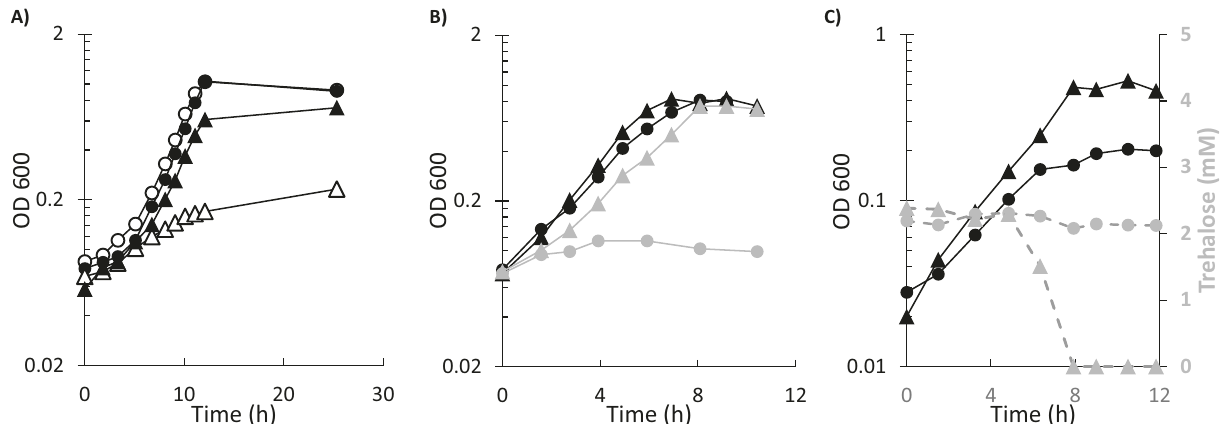
Fig. 3 Growth phenotypes of T. kivui strains. Growth of T. kivui WT (circles) and CO-strain (triangles) on: A glucose in NV medium (open shapes) or in NV medium with added thiamine ( fi lled shapes), B complex medium with 10 mM glucose (black shapes) or 5 mM trehalose (gray shapes), and C 20 g/L yeast extract as source of trehalose — optical density (black shapes), and trehalose concentration (gray shapes with dashed lines). Shown is a single representative run from biological